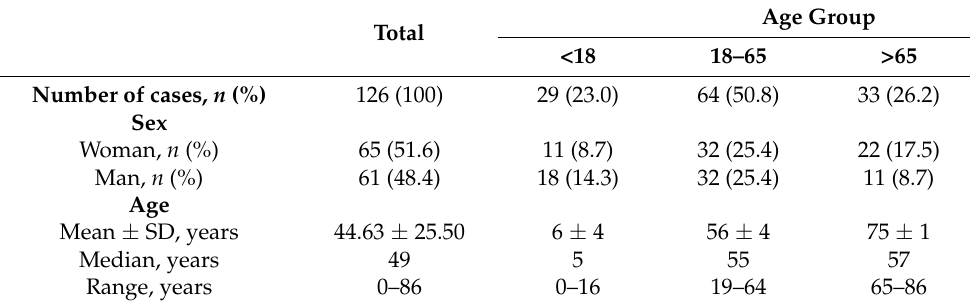
Table 3. Distribution of CL cases by age and